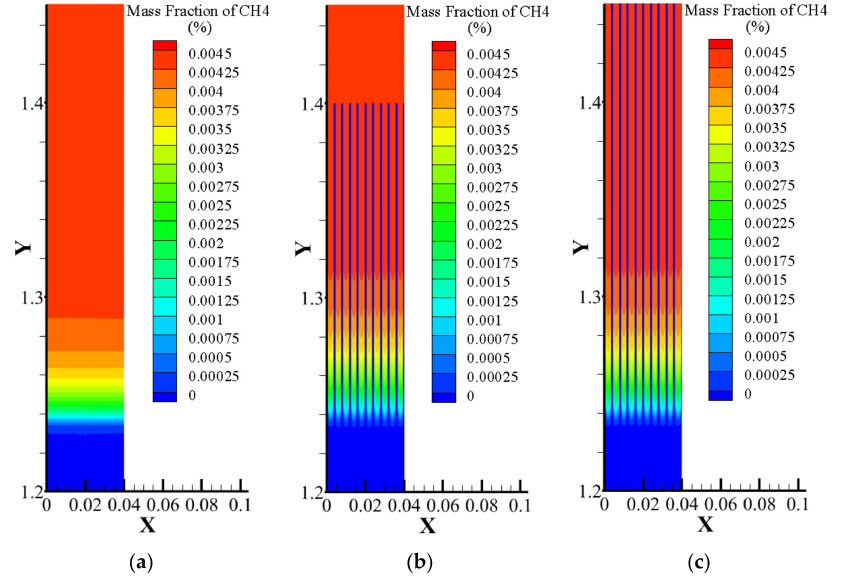
Figure 10. Mass fraction of methane contour comparison of three models at 108 s with X CH and inlet flow rate of 700 m 3 /h. ( a ) VAM model; ( b ) Multi-scale model; ( c ) PSS